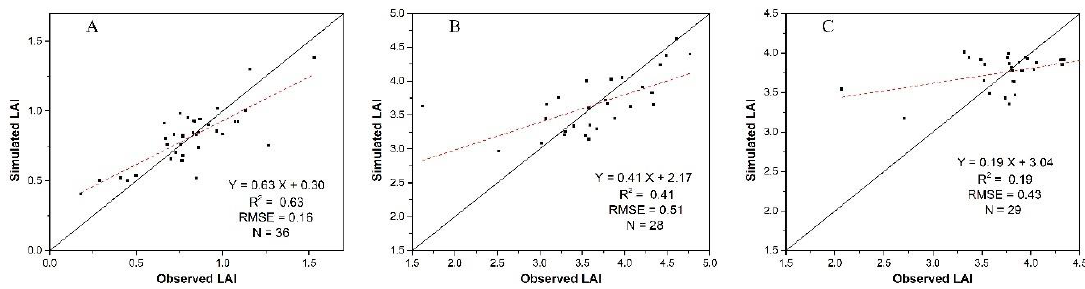
Figure 6. The accuracy of LAI estimations using the vegetation index method ( A ) 30 June, ( B ) 29 July, ( C ) 25 August.